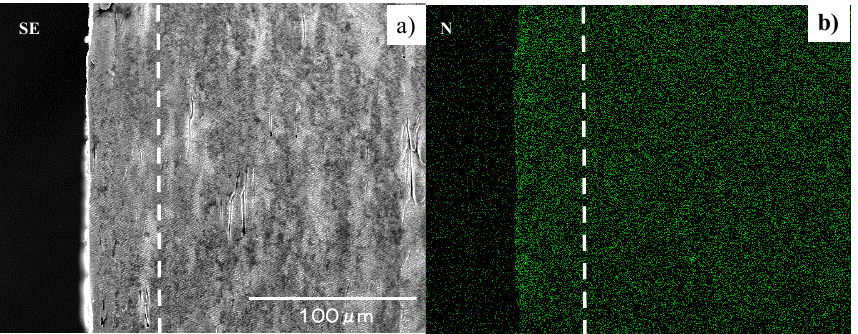
Figure 7. Detailed microstructure and nitrogen mapping of nitrided SKD11 punch. ( a ) SEM image of its cross-section, and ( b ) nitrogen mapping.